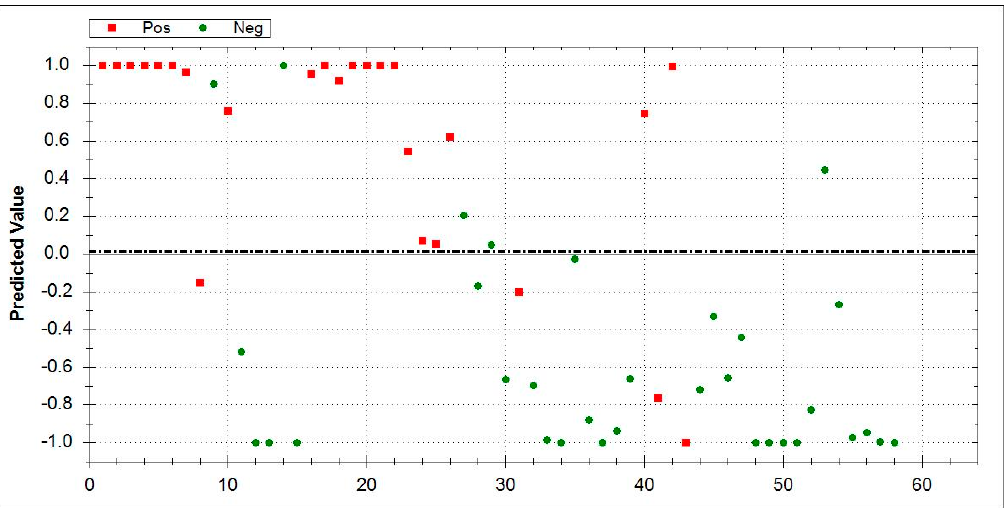
Figure 2. Direct comparison between CTD-ILD ( n = 25, red squares) and HC ( n = 33, green dots) by Aeonose ® . CTD-ILD area 0–1: Red squares indicate correctly recognized CTD-ILD patients while green dots denote false positive patients. HC area 0– − 1: Green dots represent correctly-identified healthy controls, while red squares mark false negative results. Abbreviations: CTD-ILD-connective-tissue diseases- associated ILD, HC- healthy controls.